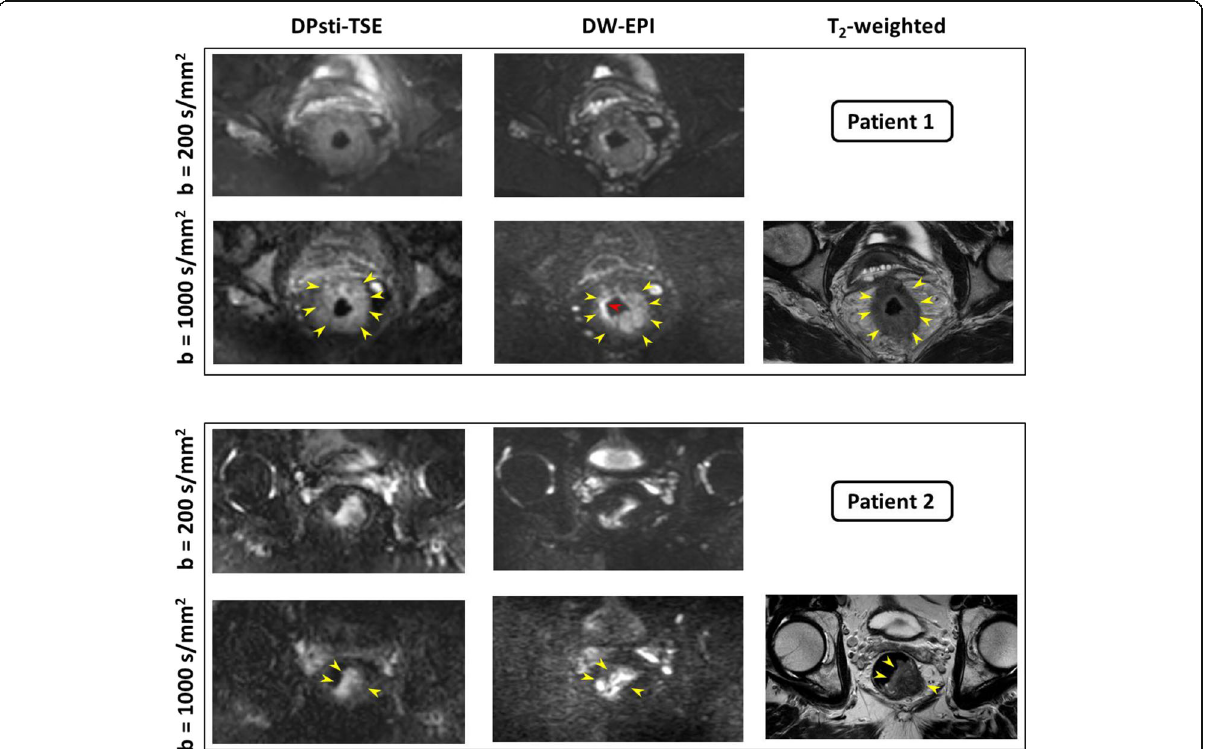
Fig. 3 Representative images for two locally advanced rectal cancer patients. Tumours are indicated by yellow arrows, which are hyperintense on the b = 1000 s/mm 2 images and hypointense on T2-weighted images. Intra-rectal gas led to minor signal pileup in DW-EPI images for patient 1 (red arrow) but more severe tumour distortion in DW-EPI images for patient 2. ( DPsti-TSE diffusion-prepared stimulated echo turbo spin-echo, DW-EPI diffusion-weighted echo-planar